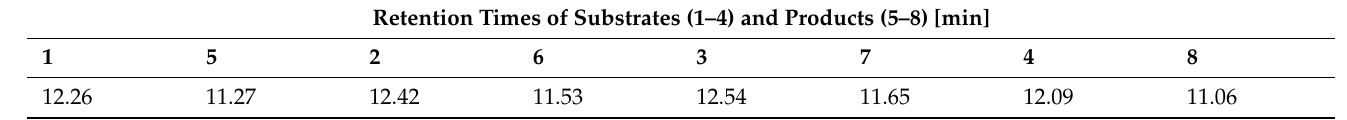
Table 8. Retention times of substrates and products based on